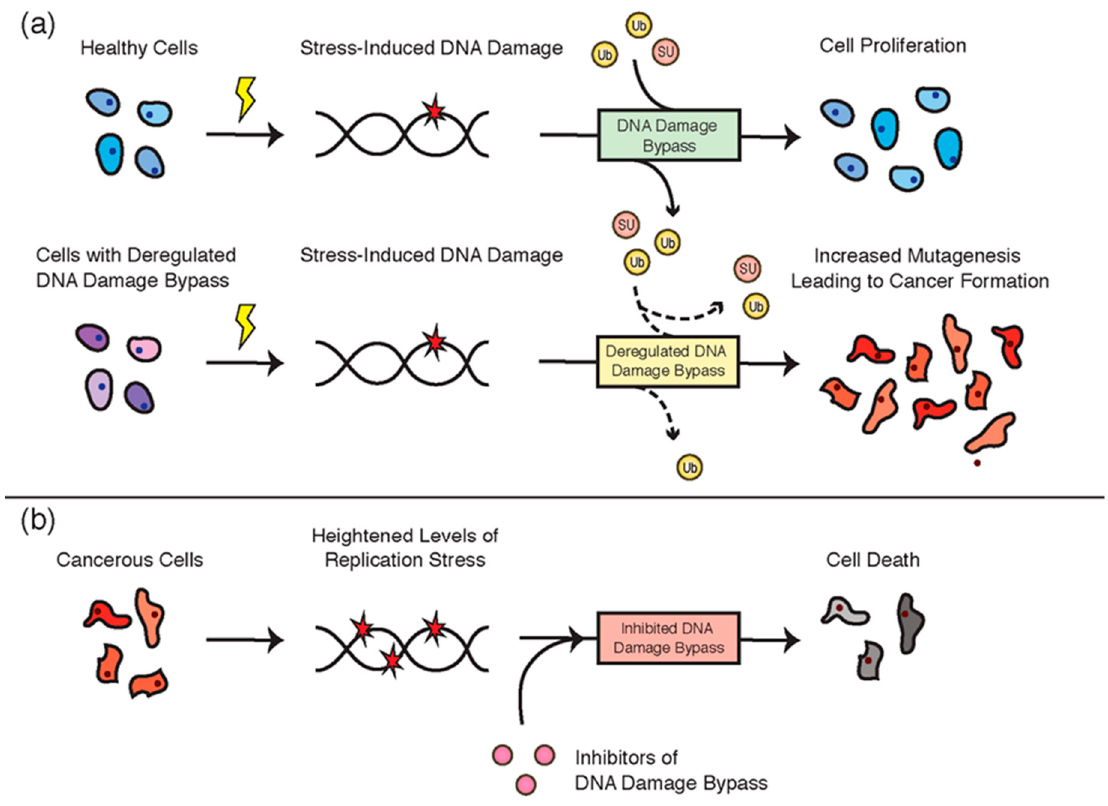
Figure 8. ( a ) The accurate regulation of DNA damage bypass by ubiquitin and ubiquitin-like proteins is essential for normal cellular function. Dashed lines indicate a deregulated flux of these modifiers. ( b ) Cancer cells experience heightened levels of cellular stress and rely on genome stability pathways such as DNA damage bypass for their survival. Targeting these pathways is a promising anti-cancer strategy.